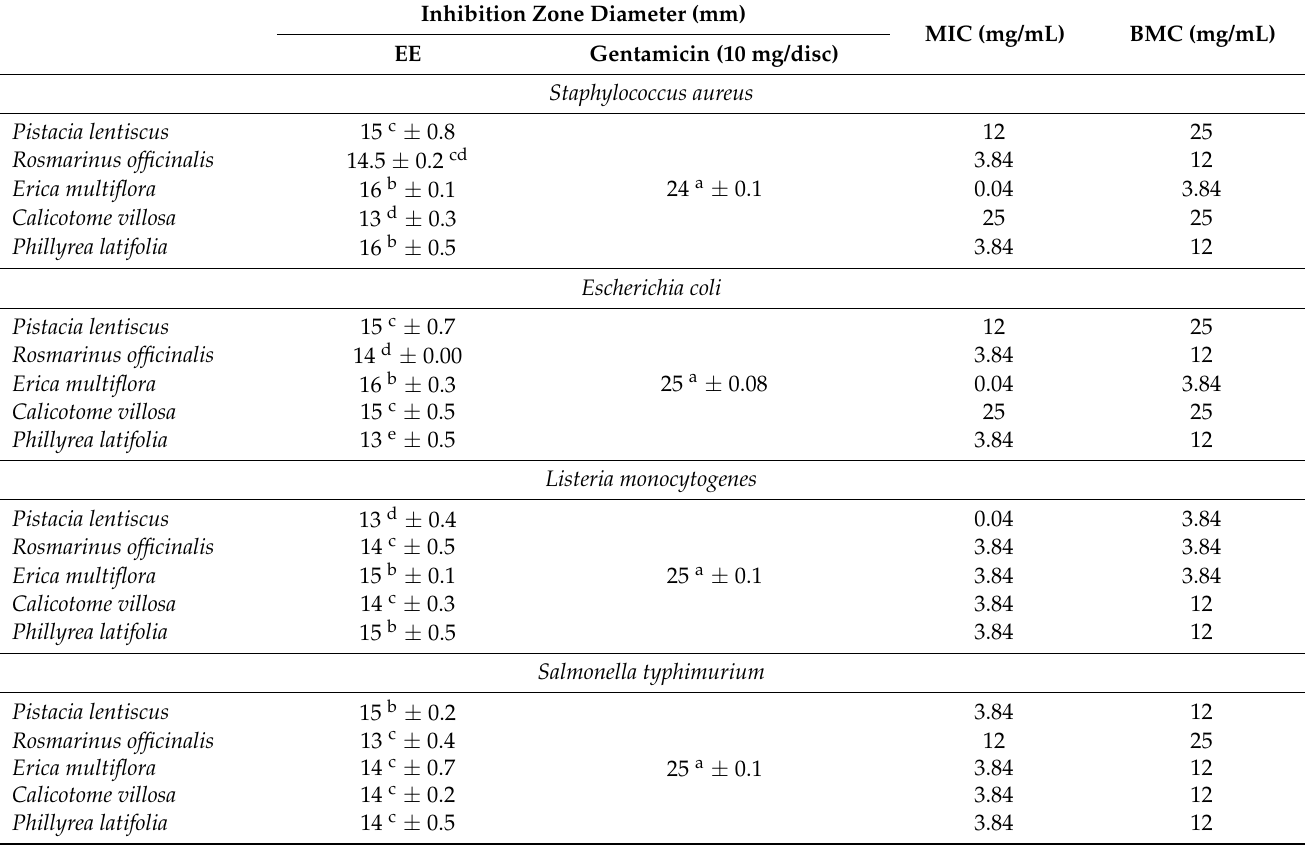
Table 2. Qualitative and quantitative results (MIC and BMC) of the antibacterial effects of the EEs of Pistacia lentiscus , Rosmarinus officinalis , Erica multiflora , Calicotome villosa , and Phillyrea latifolia on the reference strains were